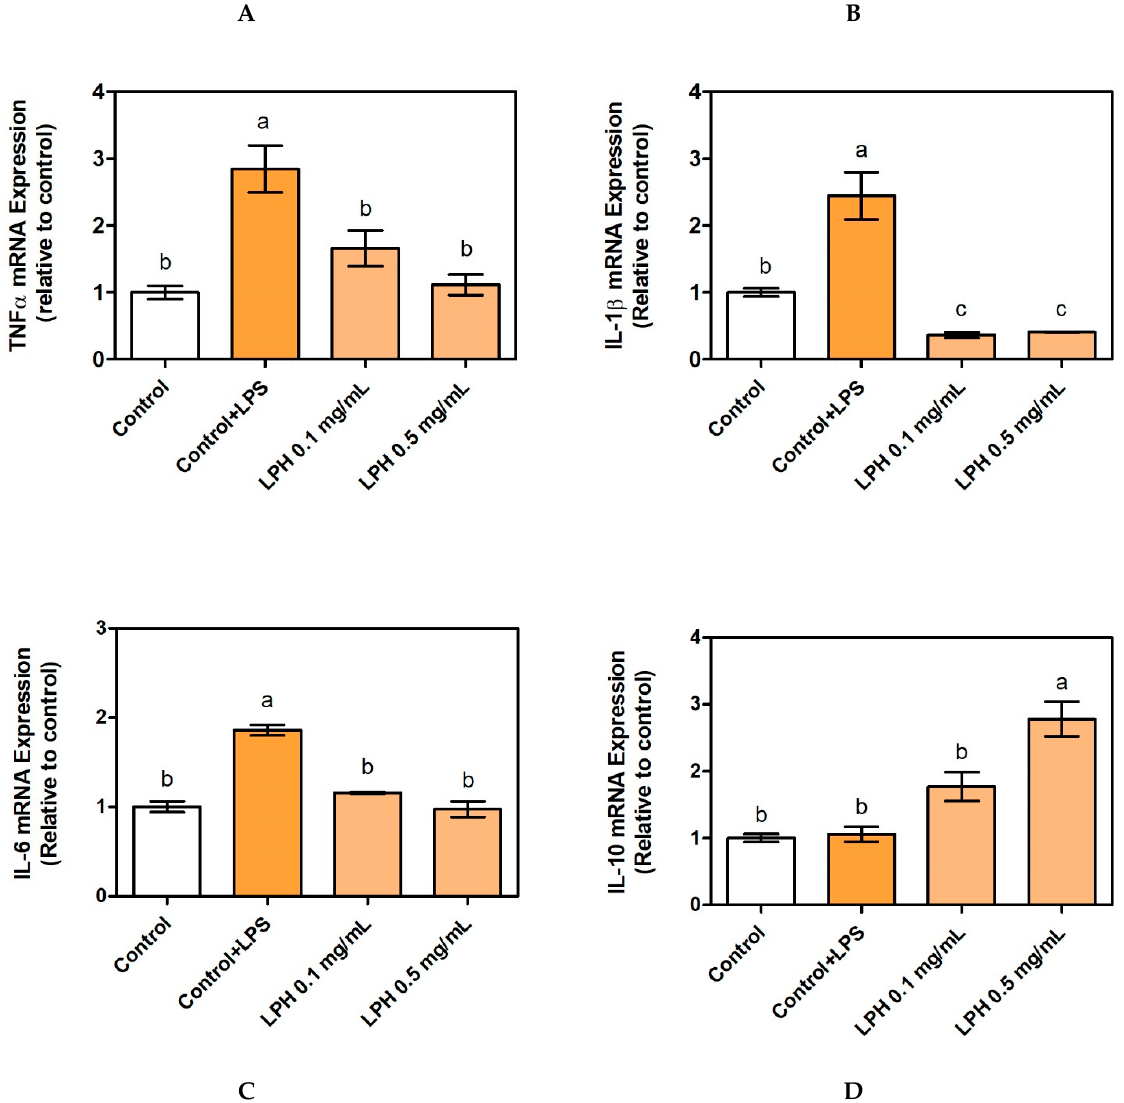
Figure 3. TNF- α ( A ), IL-1 β ( B ), IL-6 ( C ), and IL-10 ( D ) mRNA expression in THP-1-derived macrophages co-cultured with Caco-2 cells in Millicell® system and treated with or without LPS (100 ng/mL) and LPH at 0.1 and 0.5 mg/mL. Values are presented as means ± SD ( n = 3) and those marked with different letters are significantly different ( p <